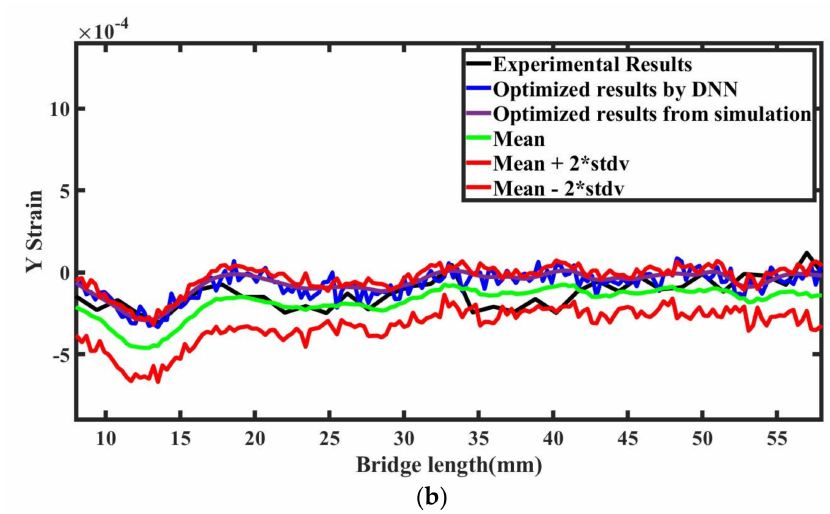
Figure 21. Confidence intervals of simulation results from DNN model and for the optimized parameters obtained from PSO. ( a , b ) represent the x and y strains,